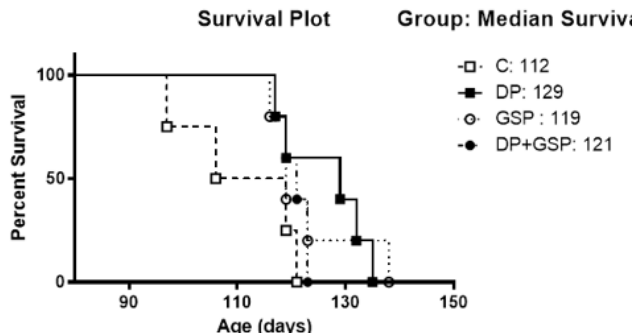
Figure 8. E ff ect of treatment on survival. A Kaplan–Meier survival plot of study groups shows that the DP group shows a trend toward increasing lifespan. No statistically signi fi cant di ff erences ( p = 0.07). Median survival times (days alive) for each group are also